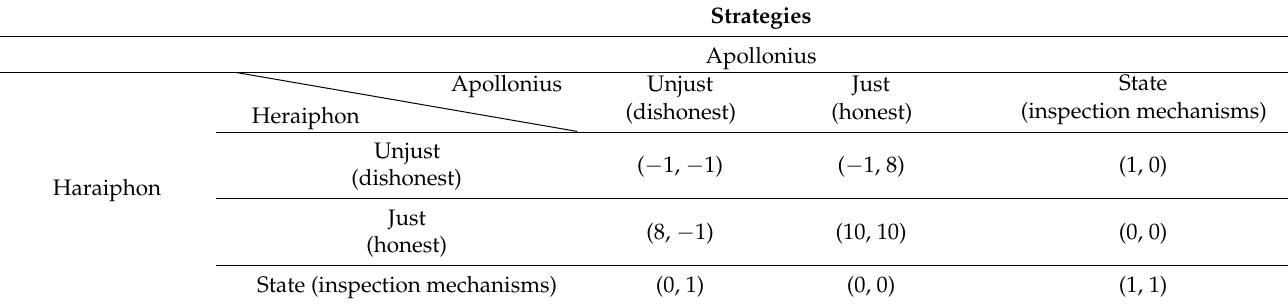
Table 2. Payoffs of the second stage—both players do not trust each other.